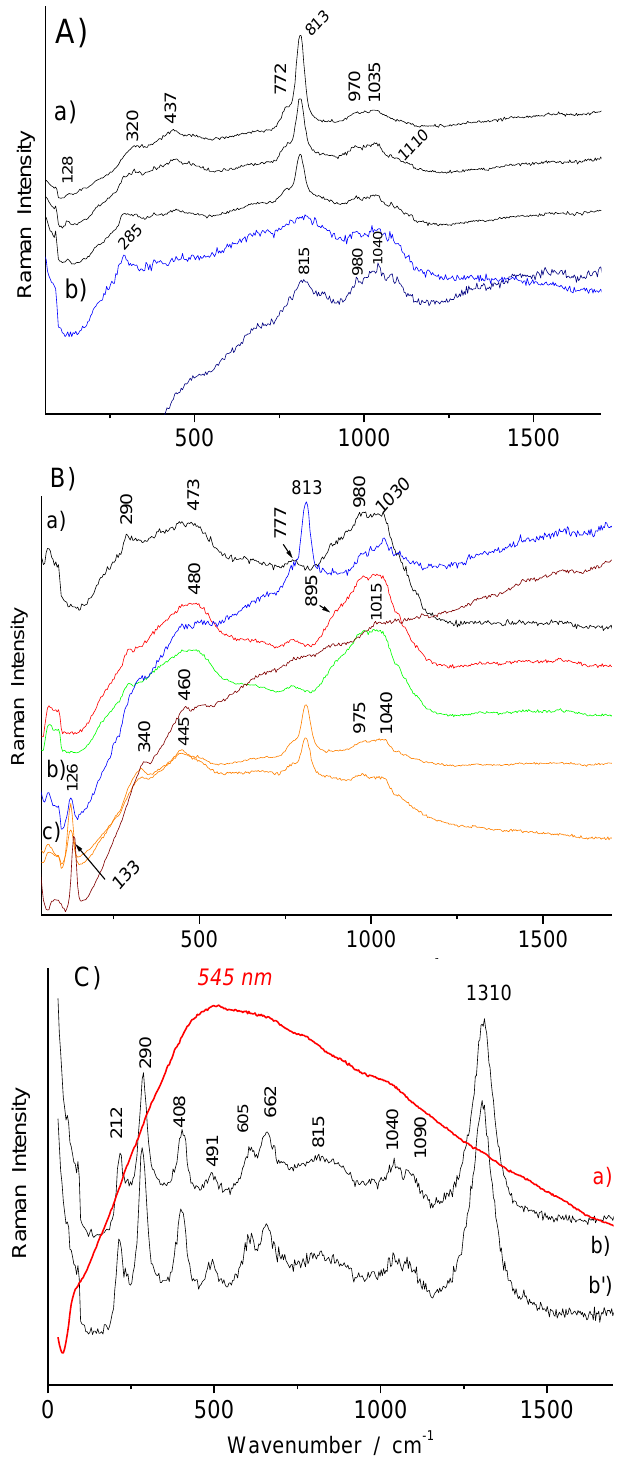
Figure 15. Representative Raman spectra recorded on the F1341C porcelain vase (Qianlong period) for different coloured areas: ( A ) white (a) and blue (b); ( B ) green (a) and yellow (b,c) ; ( C ) orange (a) and red (b,b′).